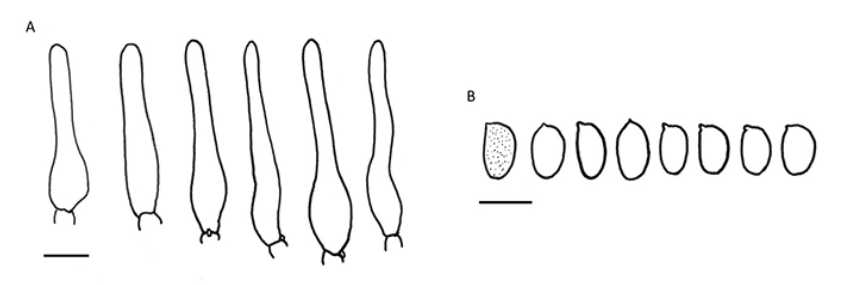
Figure 7 Microcharacters of Hebeloma subtortum P. Karst.: ( A ) cheilocystidia; ( B ) spores. Scale bars: 10 µ